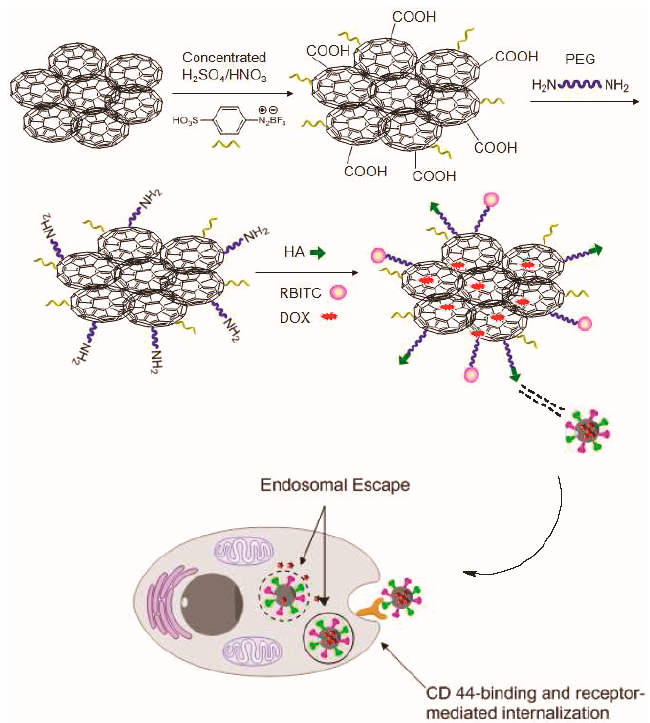
Figure 3. Synthetic path of DOX loaded HA-Q-G-RBITC multifunctional nanosheets and HA-Mediated Endocytosis [78].